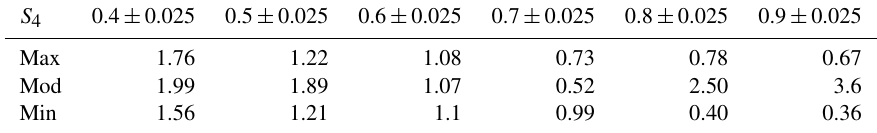
Table 4. Average values of the fading coefficient α as a function of the S 4 scintillation index for different solar activity levels.